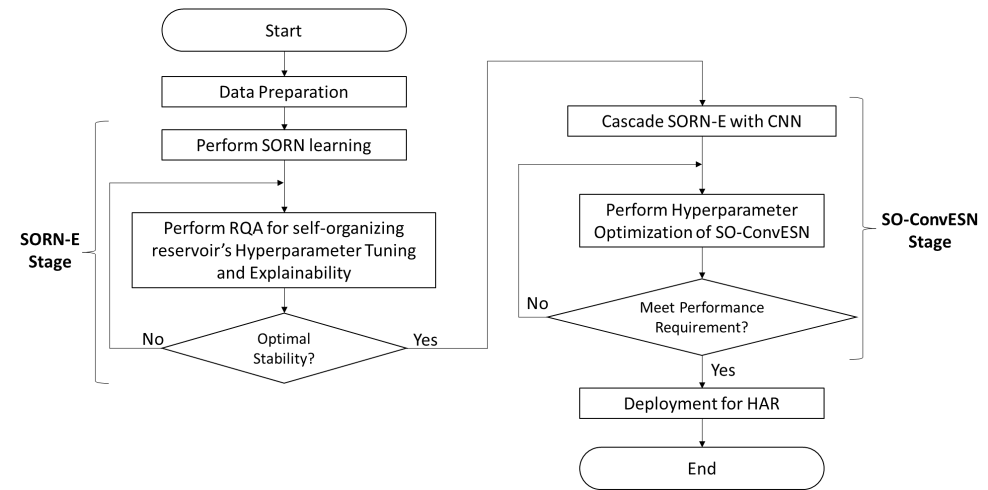
Figure 1. Development framework of the Proposed SO-ConvESN for HAR. It consists of two key components: the SORN-E stage and the SO-ConvESN